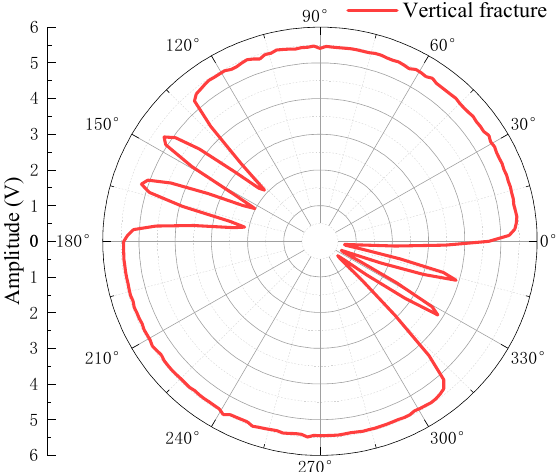
Figure 23. Echo amplitude of vertical fracture.